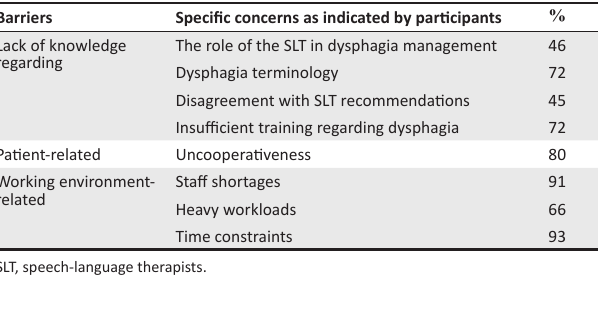
TABLE 1: Summary of barriers to compliance with speech-language therapists’ dysphagia recommendations (as indicated by the percentage of responses).